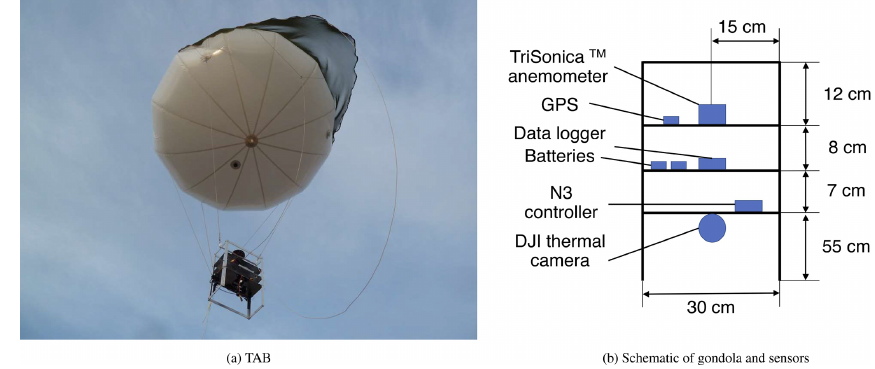
Figure 1. Close-up of the TAB system during sampling and the schematic of the TAB gondola with all the sensors.